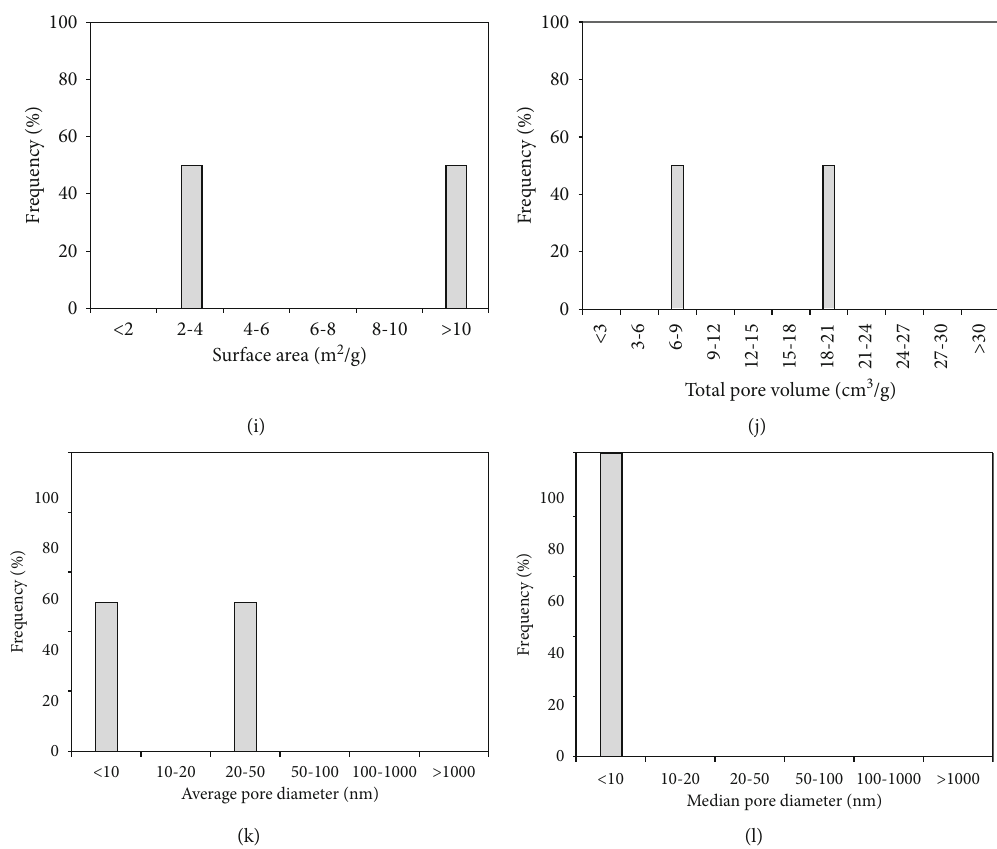
Figure 13: The frequency distribution of the surface area (a, e, and i), total pore volume (b, f, and j), average pore diameter (c, g, and k), and median pore diameter (d, h, and l) of di ff erent types of shale. The data of the surface area is from N and HPMI, the average pore diameter is from N